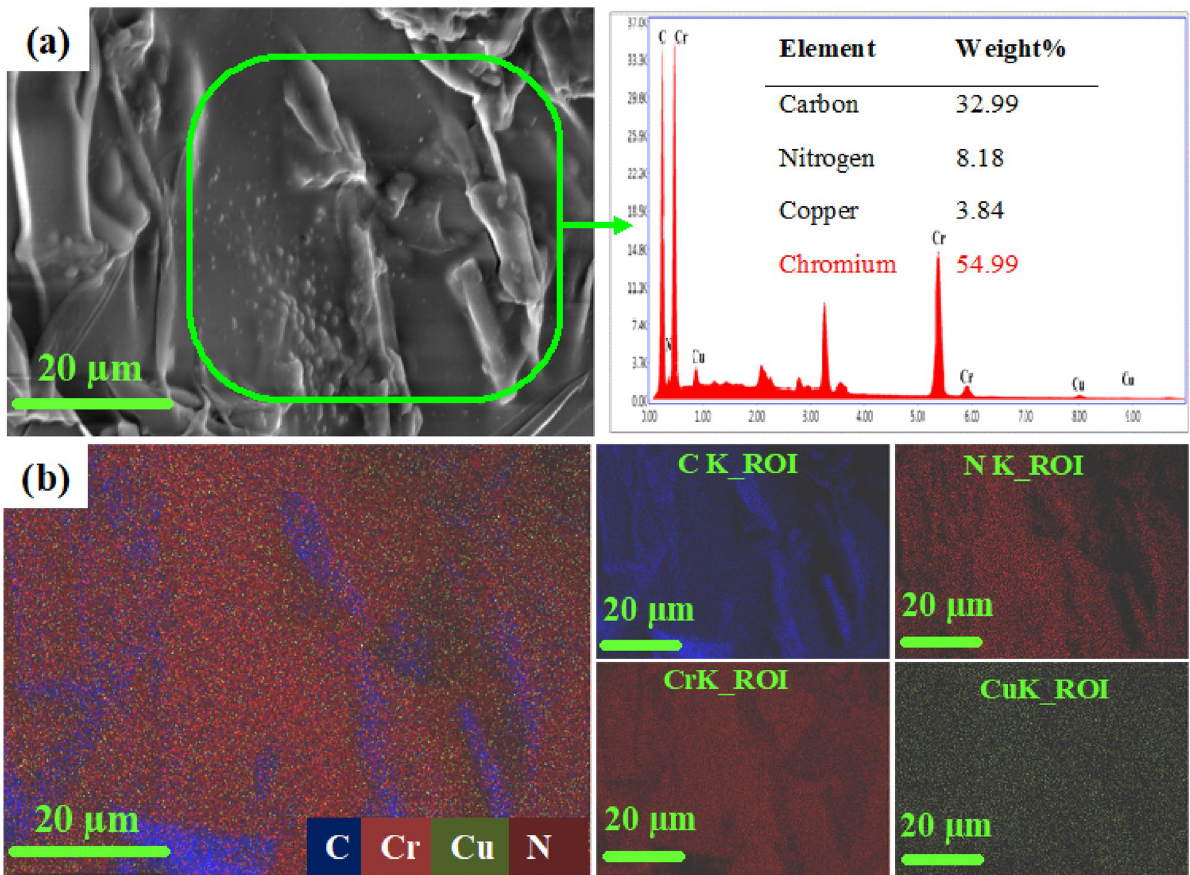
Figure 3. Elemental analysis of the Cr adsorbed PMC sample ( a ) elemental analysis, and ( b ) elemental mapping.